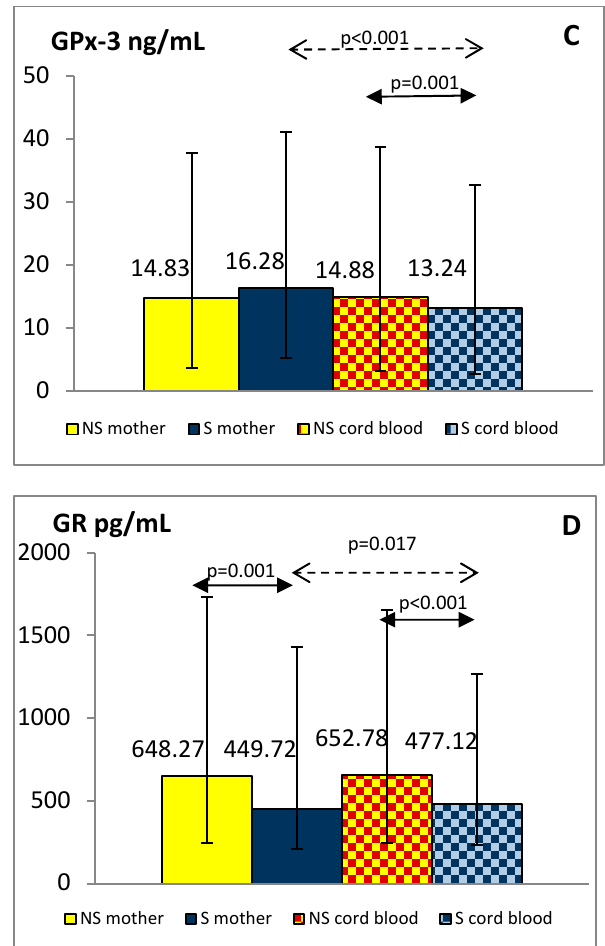
Figure 2. Levels of GSH ( A ), GSSG ( B ), GPx-3 ( C ) and GR ( D ) in the plasma of smoking (S) and non- smoking (NS) mother-newborn pairs. The results are presented as the median and interquartile range (1Q-3Q); GSH—reduced glutathione, GSSG—oxidized glutathione, GPx-3—glutathione peroxidase 3, GR—glutathione reductase.